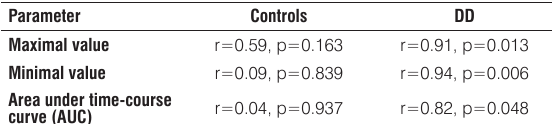
Figure 2. Mean changes in serotonin levels during postprandial time in study participants stratified by diverticular disease (DD) presence (A) or bowel habit (B). and minimal values as well as area under time-course curves following a test meal in patients with diverticular disease (DD) and healthy